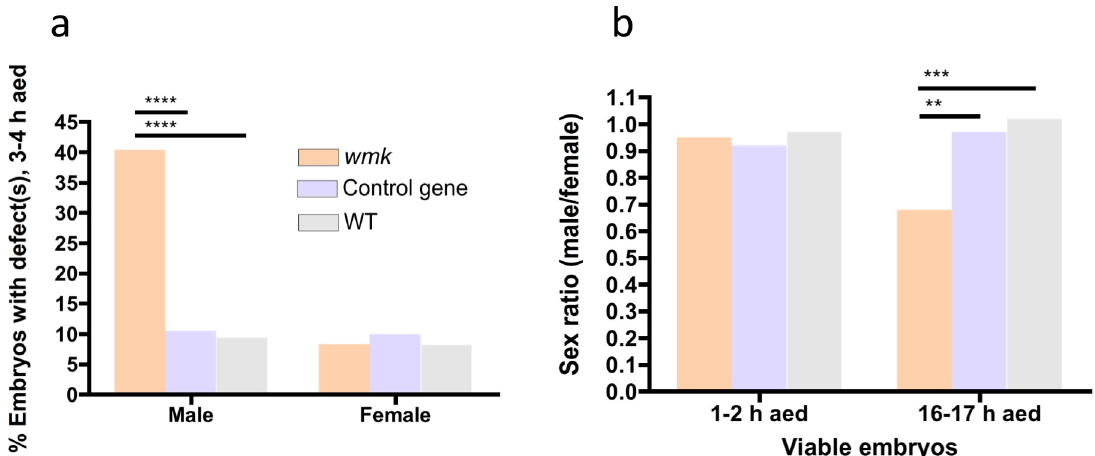
Fig 4. wmk -induced embryonic defects are enriched in males. Data are from pooled embryos (both sexes, expressing and non- expressing, see methods) with either wmk , the control gene, or a WT background. (A) Graph quantitating the percentage of 3–4 h AED embryos (males or females) that have at least one defect ( wmk males N = 228, control gene males N = 190, WT males N = 170, wmk females N = 240, control gene females N = 200, WT females N = 158). (B) Graph quantitating the sex ratio of viable embryos (not degraded, no visible defects) across two development times (1–2 h wmk , N = 105 m, 111 f; 1–2 h control gene, N = 30 m, 141 f; 1–2 h WT, N = 112 m, 115 f; 16–17 h wmk , N = 104 m, 154 f; 16–17 h control gene, N = 116 m, 120 f; 16017 h WT, N = 110 m, 108 f). m = male, f = female. Statistics were performed with a Chi-square test comparing the three genotypes within each category (male or female in (A) and 1–2 h or 16–17 h in (B)). These experiments were performed once. �� p < 0.01, ��� p < 0.001, ���� p < 0.0001.